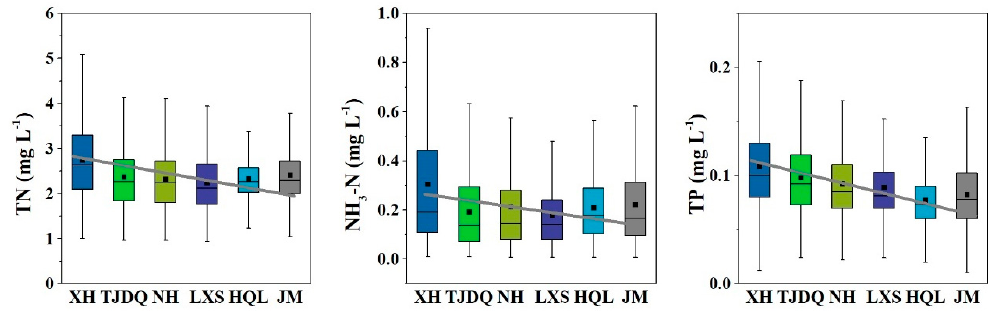
Figure 5. Concentration of nutrients (TN, NH 3 –N and TP) in the estuarine water from six sites from 2008 to 2017 in Nansha, Guangzhou. The sampling sites are ranked according to their distance from the city center: XH < TJDQ < NH < LXS < HQL < JM. The boxes represent the 25th and 75th percentiles, and the whiskers represent the minimum and the maximum. The horizontal bars within boxes represent median. The black points inside boxes represent mean. All outliers are not shown.